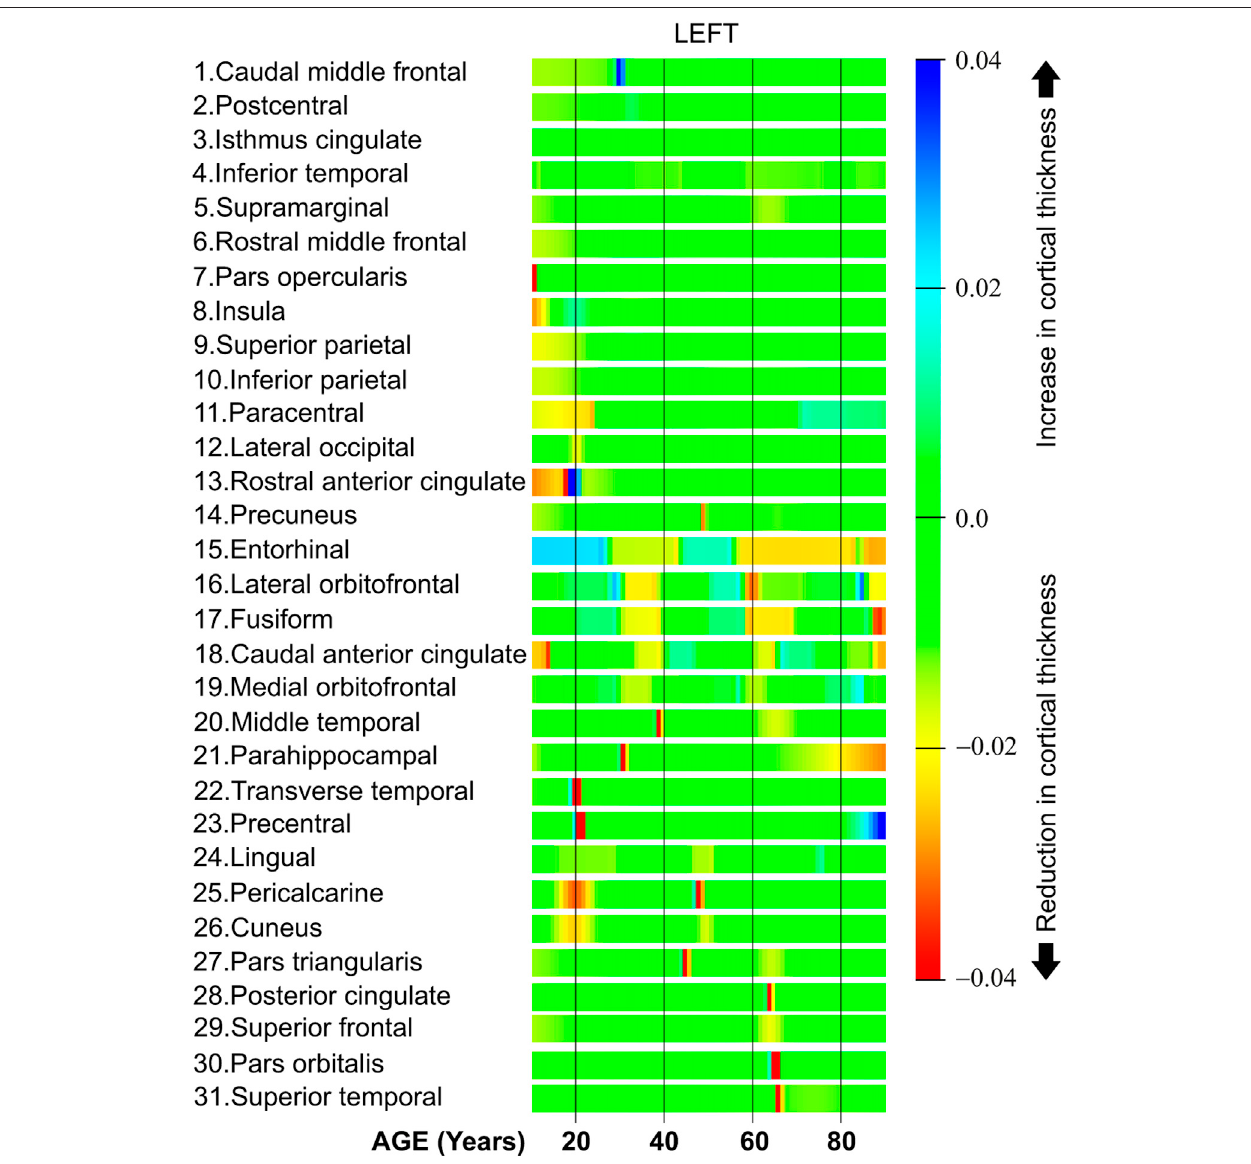
FIGURE 8 | Cortical thickness derivative with respect to age, left